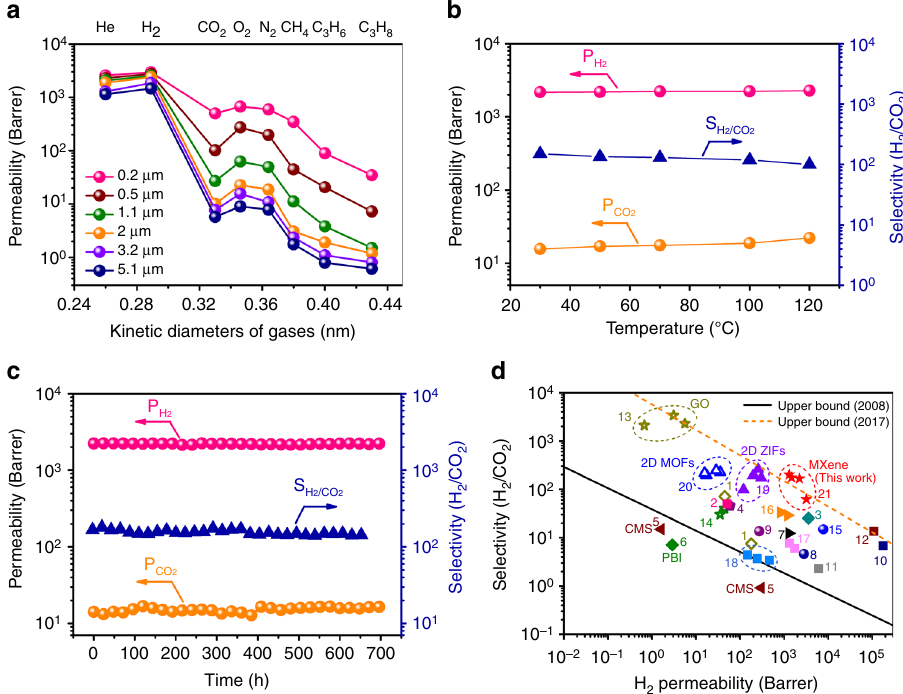
Fig. 3 Gas separation performance of the MXene membrane. a Single-gas permeabilities through the MXene membranes with different thicknesses at 25 ° C and 1 bar. b H 2 /CO 2 separation performance of a 2- μ m-thick MXene membrane as a function of temperature in the equimolar mixed-gas permeation. c Long-term separation of equimolar H 2 /CO 2 mixture through a 2- μ m-thick MXene membrane at 25 °C and 1 bar. d H 2 /CO 2 separation performance of the MXene membrane compared with state-of-the-art gas separation membranes. The black line indicates the Robeson 2008 upper bound of polymeric membranes for H 2 /CO 2 separation 58 , and the orange dashed line represents the 2017 upper bound of the best current membranes for H 2 /CO 2 separation. Information on the data points is given in Supplementary Table